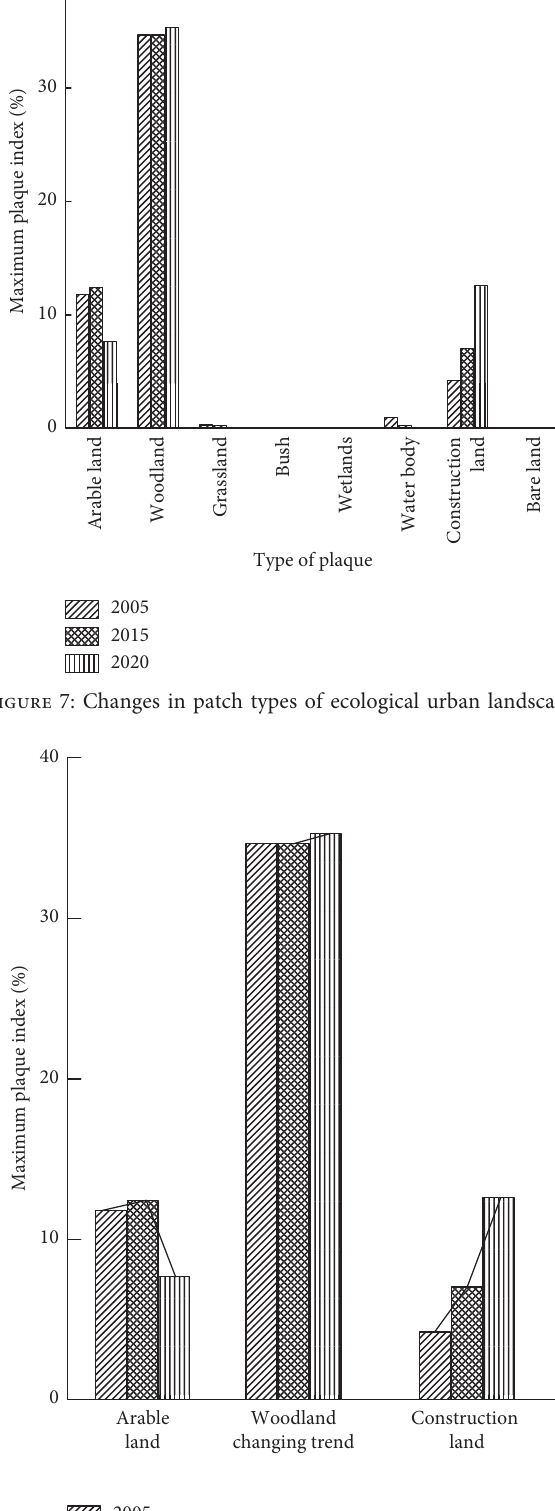
Table 3: The overall composition and changes of the ecological urban landscape pattern.